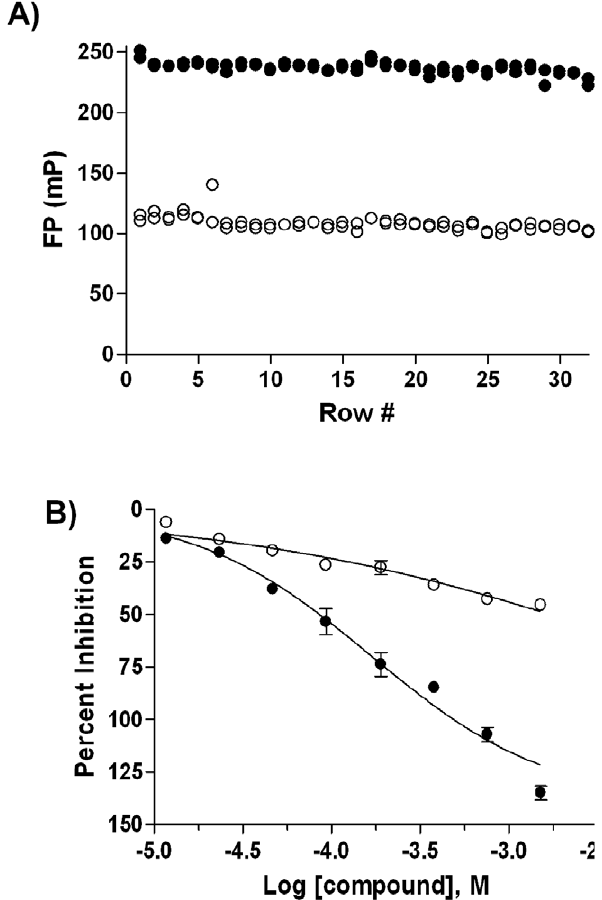
Figure 3. HSA Assay Miniaturization to 1536-well Format. A) N whole-plate scatter plot obtained from 10 m M HSA/3 m M Dansyl N ) and 3 m M Dansyl sarcosine ( # ); B) concentration- sarcosine mix ( ) and Phenylbutazone ( # ) in 1536- response profiles of Naproxen ( well format.